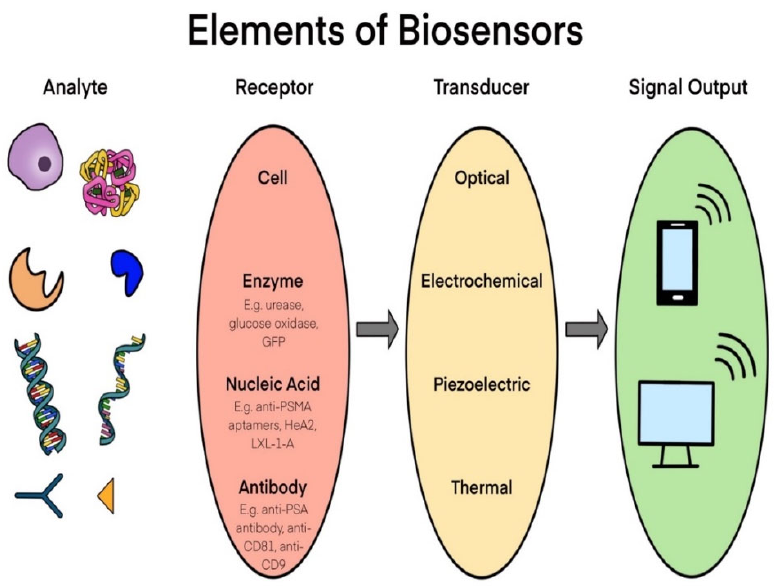
Figure 1. General schema of biosensor device workflow.